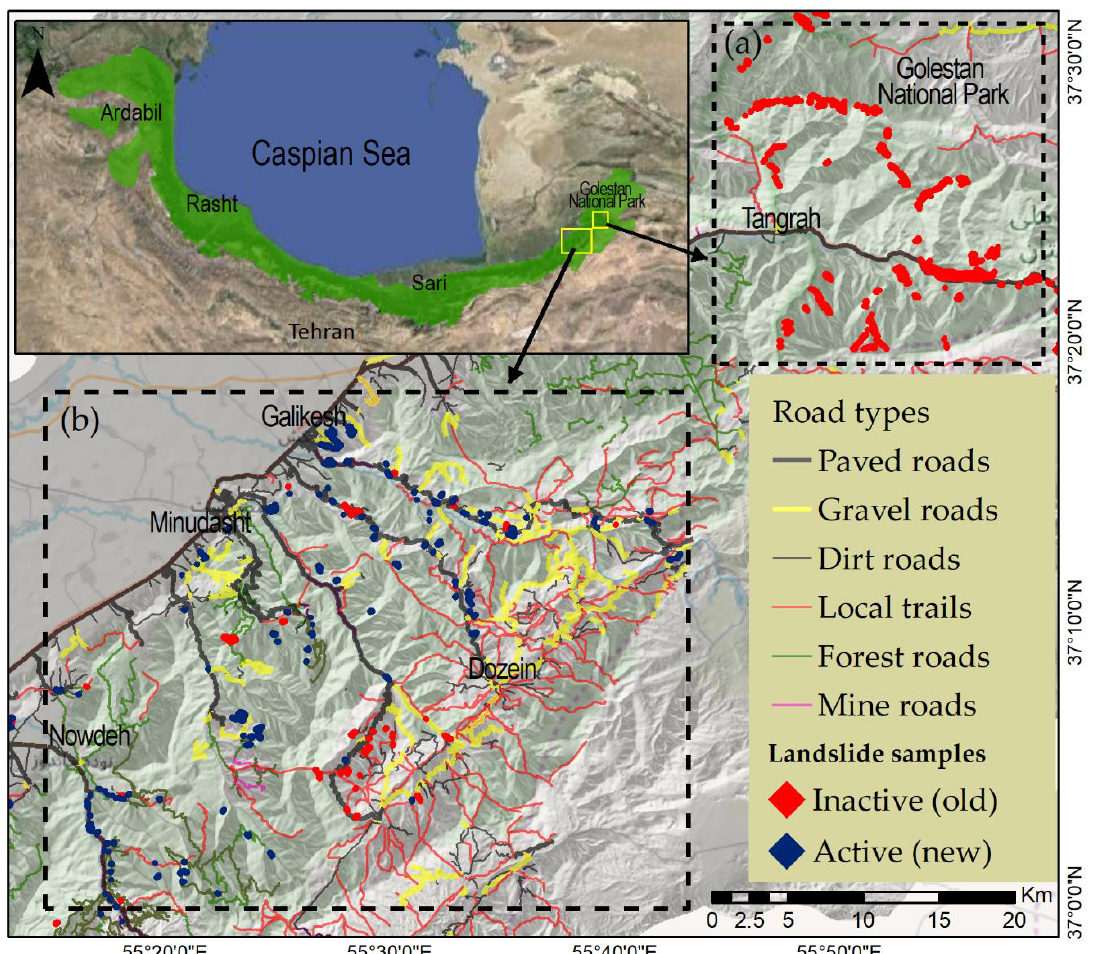
Figure 1. Location of the study areas in the Hyrcanian ecoregion, NE Iran. The Golestan National Park was studied as the protected forests ( a ), with minimum human-intervention and mostly old landslide events. Forests with intensive human activities were selected as the non-protected forests ( b ), this area has been affected by the domination of active landslide events.